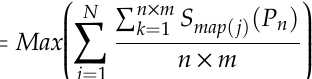
Figure 1. Proposed framework for violent scene detection in movies.